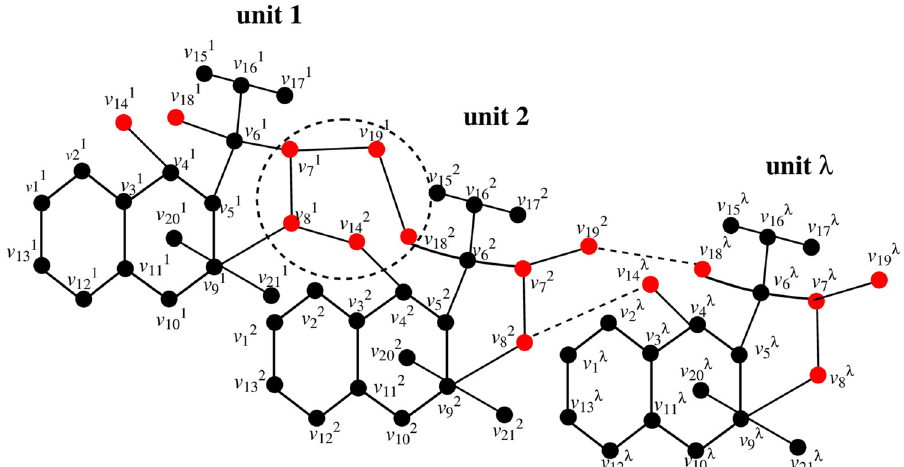
Figure 1: Supramolecular chain of complex -